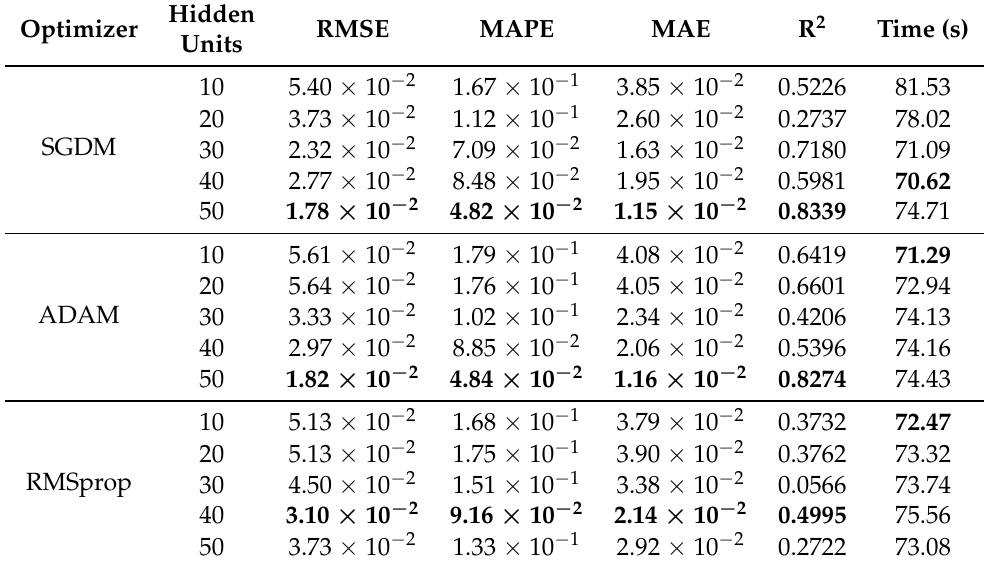
Table 2. Evaluation of LSTM hyperparameters.